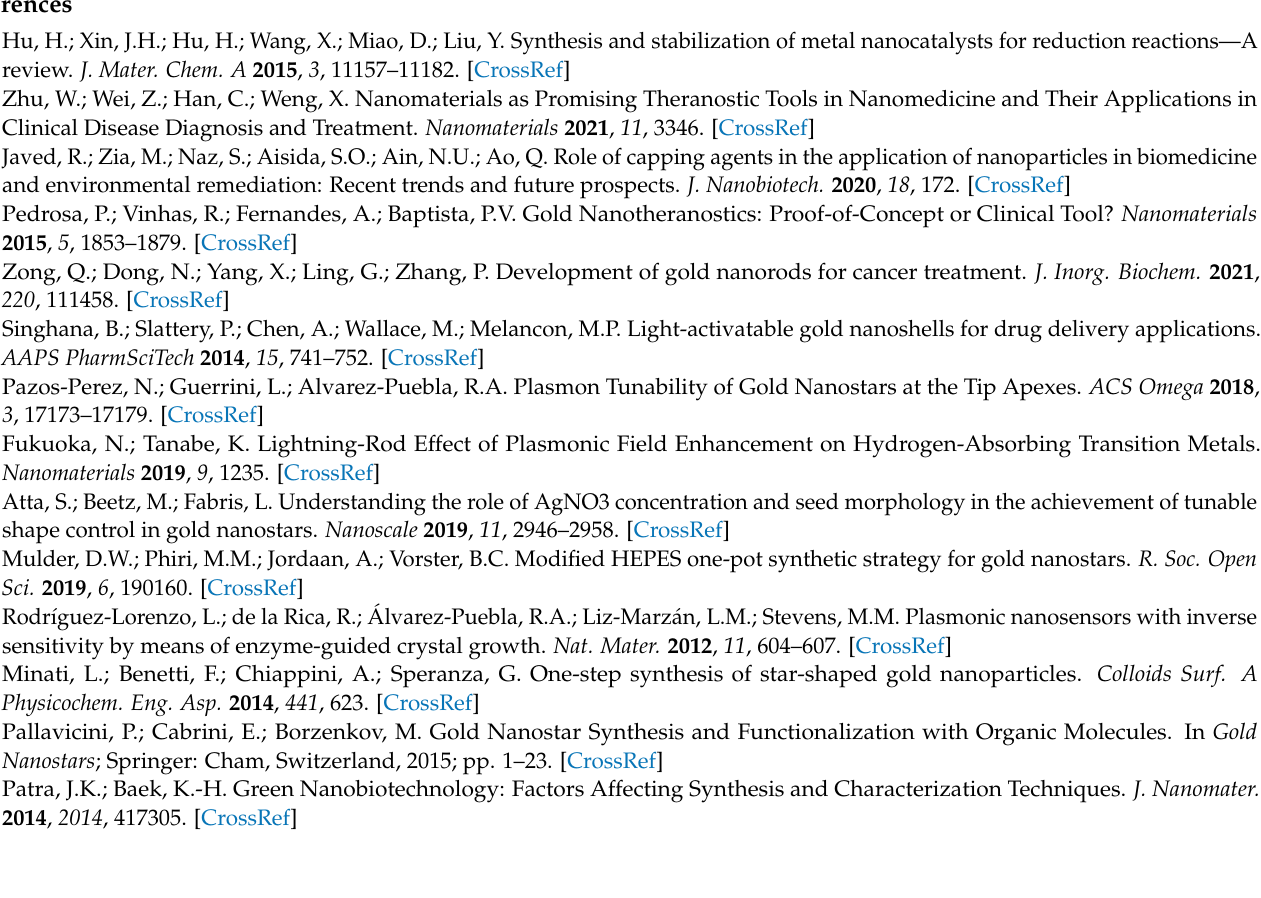
Figure S3: Hydrogen-peroxide-sensing efficacy UV-vis spectra; Figure S4: UV-vis spectra and colori- metric readouts for GOx-spiked